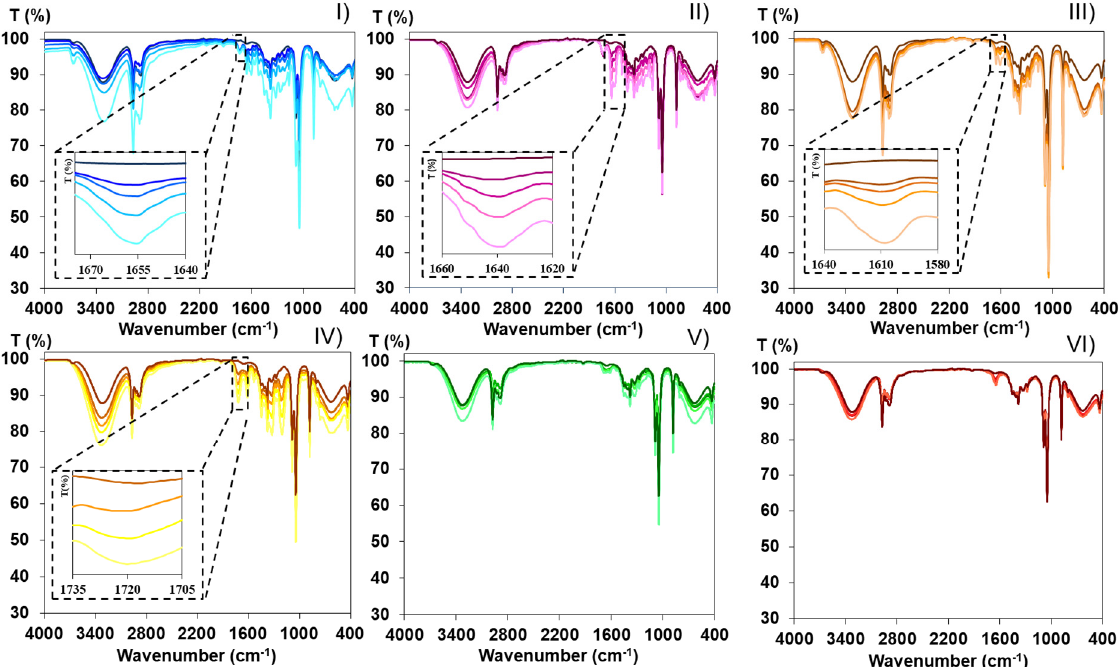
Figure 3. FTIR–ATR spectra of 1, 2, 4 and 8 mg·mL − 1 of ( I ) quercetin, ( II ) naringenin, ( III ) luteolin, ( IV ) tannic acid, ( V ) gallic acid and ( VI ) hesperidin dissolved in ethanol. Spectrum of pure solvent is presented with darker color, while the spectrum of the dissolved compound in solvent has a lighter intensity with the color intensity increasing with compound concentration.